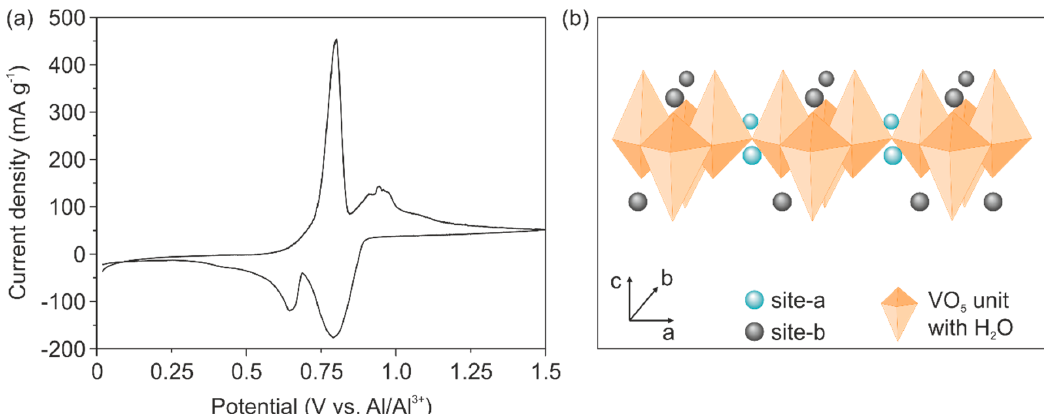
Figure 2. ( a ) Cyclic voltammetry curve of the second cycle at a scan rate of 0.1 mV s − 1 revealing two de ‐ /intercalation potentials. ( b ) Schematic illustration of the two different intercalation sites near